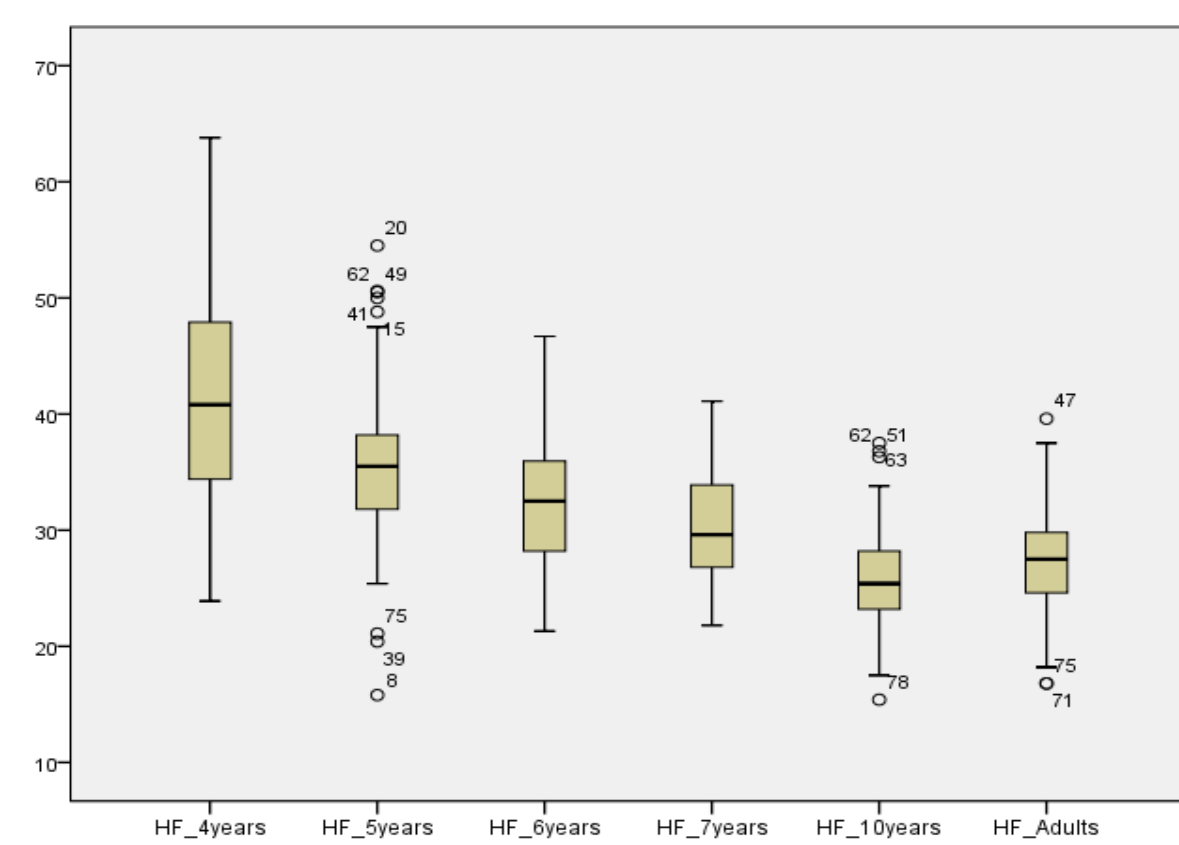
Figure 9. Comparison of mean SRT values in high frequency across age groups. In quiet, an age-dependent threshold difference of about 13 dB between younger and older children was observed. These findings are also plotted against other AAST versions for comparison. See Figure 10.